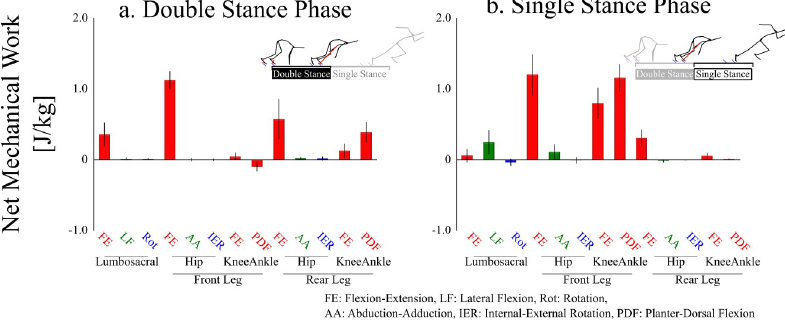
Fig 6. Mean ± standard deviation of net mechanical work during double-stance (a) and single-stance (b)